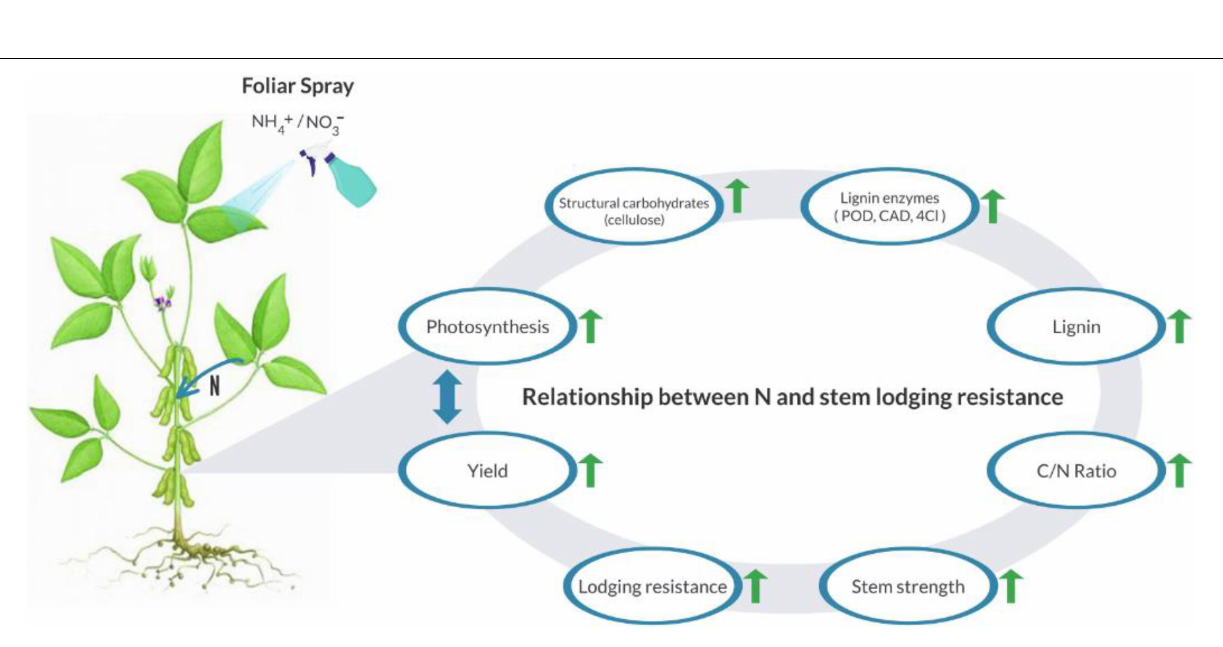
FIGURE 10 | An illustration exhibiting that, different NH 4 + /NO 3 − ratios up-regulated the physiological and biochemical mechanisms and ultimately enhanced the lodging resistance of soybean stem and yield. The upward green arrow shows the up-regulation of the following parameters and double head blue color arrow depicts the relationship between photosynthesis and